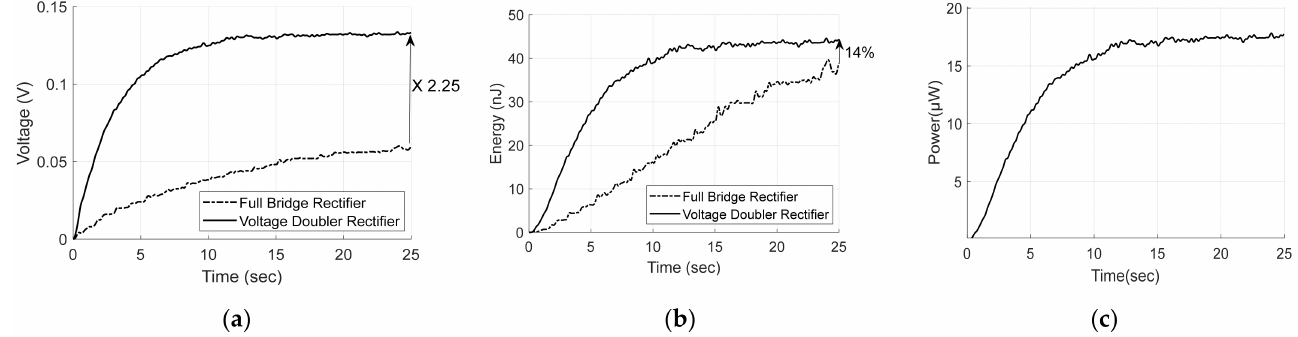
Figure 19. VDR and FBR outputs ( a ) Rectifier voltage; ( b ) Charged energy; ( c ) Output power of VDR for 1 k Ω